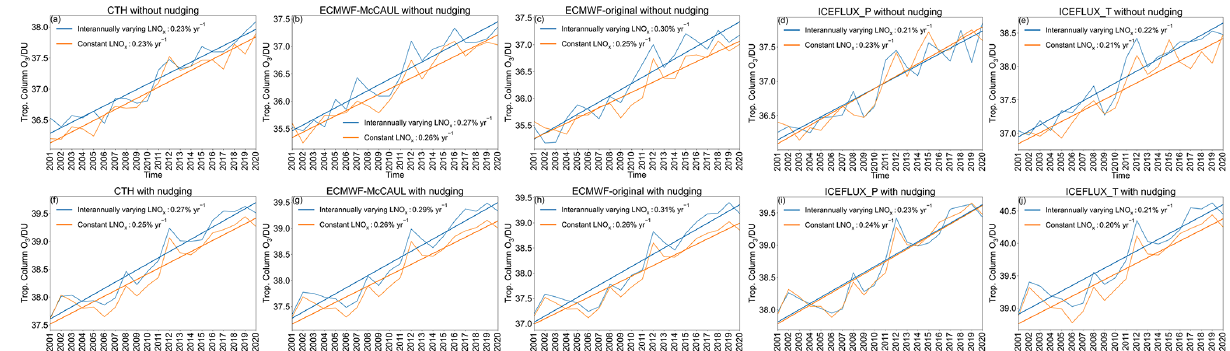
Figure 16. Trends of global mean tropospheric O 3 columns calculated from simulation results (2001–2020) using different lightning schemes. Straight lines in the figure are the fitting curves. The number in the legend represents the trend corresponding to that figure in the unit of percent per year (%yr − 1 ). Panels (a) – (e) present results obtained without nudging; panels (f) – (j) show results obtained with